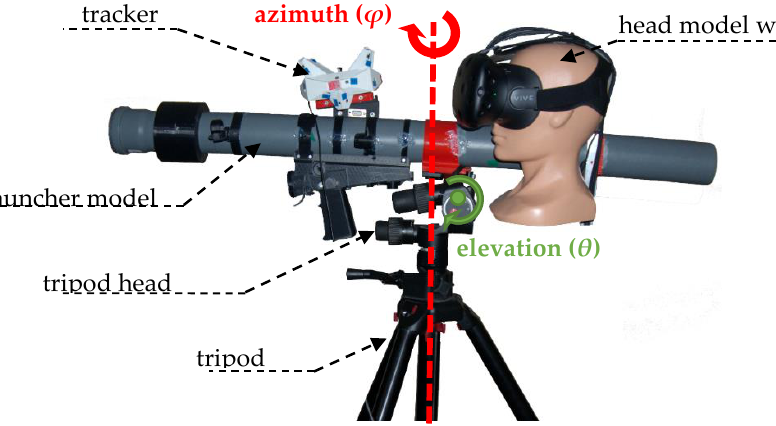
Figure 3. Photo of the launcher model with the mounted tracker and the user’s head model.